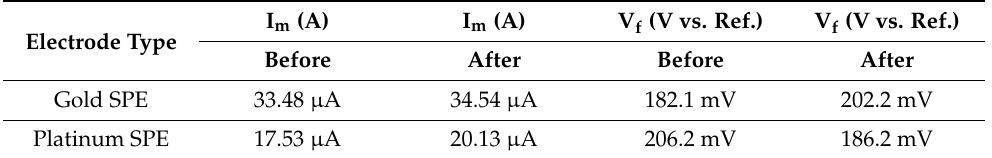
Table 7. Faradaic current peak I m and faradaic potential V f , before electrochemical cleaning versus faradaic current peak I m and faradaic potential V f versus after electrochemically